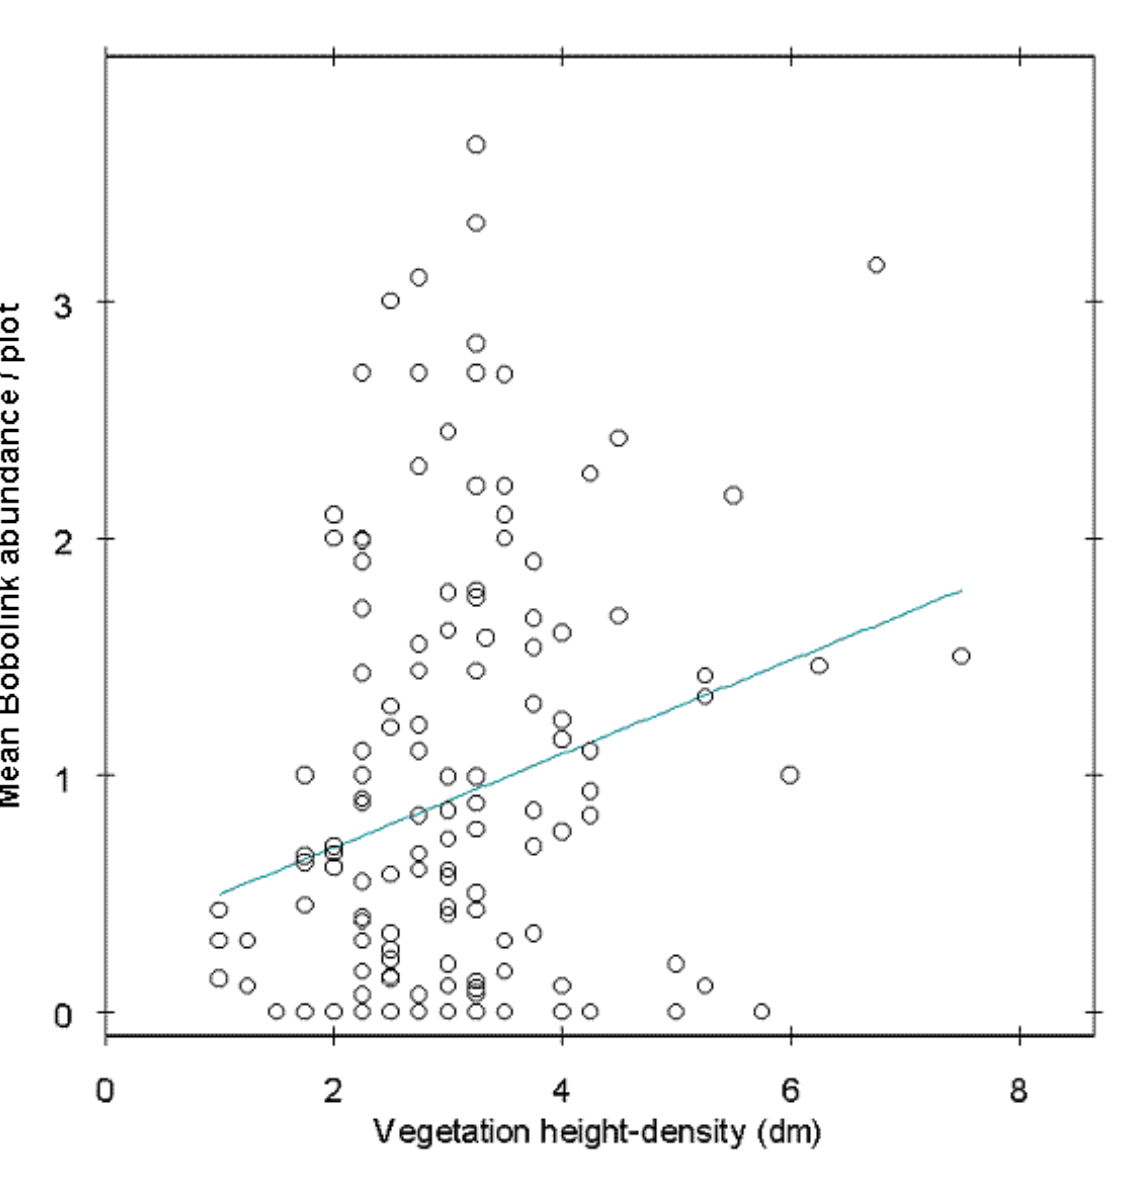
Fig. 1. Mean abundance of Bobolink/point-count station as a function of vegetation height-density in dm, determined using method of Robel et al. 1970 in May. Although linear mixed-effects models were used, least-squares trendline is shown to illustrate direction of